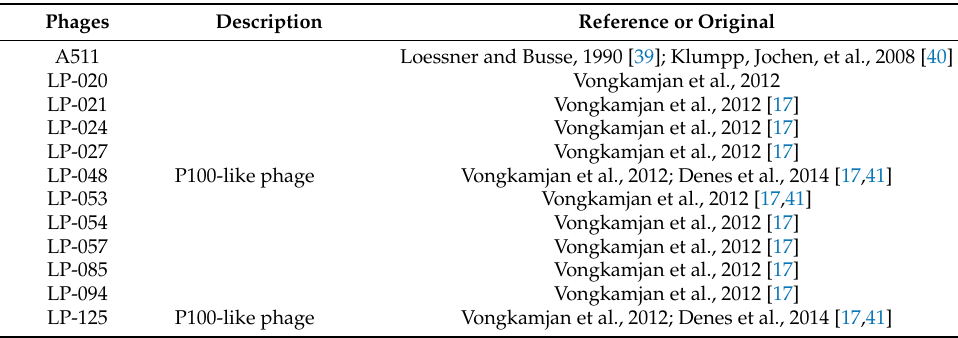
Table 2. Listeria monocytogenes